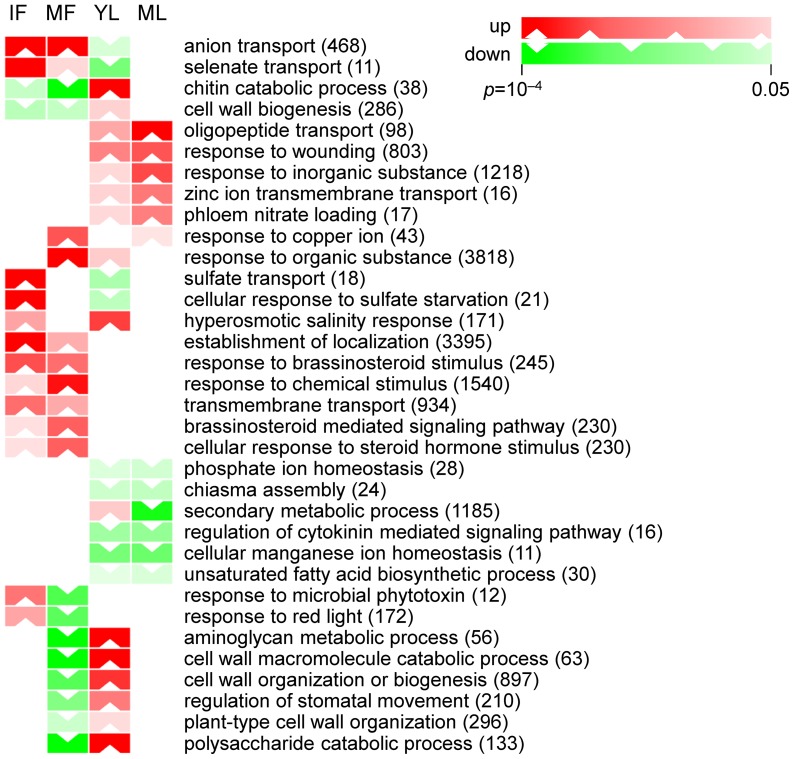
Gene Set Enrichment Analysis based on sparse principal component analysis (sPCA).GO terms representing differentially regulated functional classes of genes in at least two of the four tissues (p<0.05). Color values correspond to p-values, as indicated by color bars. Total genes in each gene set (more than ten genes) are given in parentheses. Each column represents one of four tissues: IF, immature fruits; MF, mature fruits; YL, young leaves; ML, mature leaves. Complete GSEA results, including sets with <10 genes, and enriched in one tissue only, are given in Dataset S2.